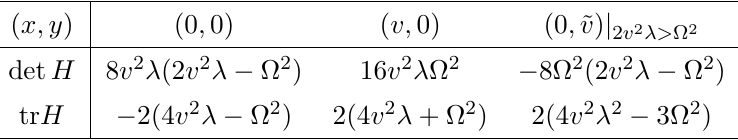
Table 1 . Determinant and trace of the Hessian H